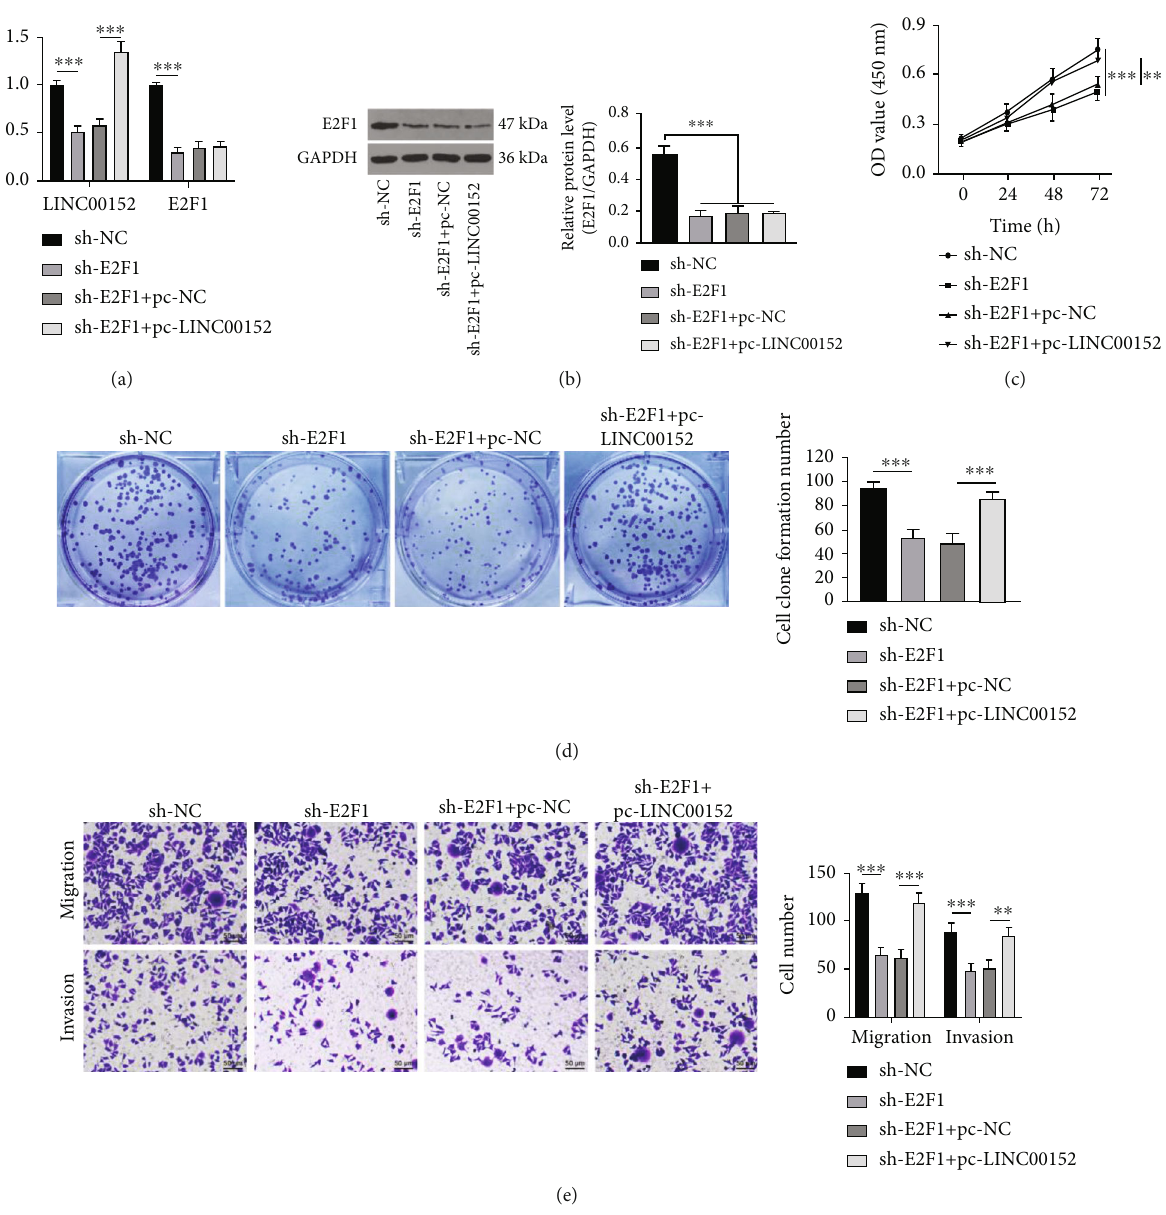
Figure 3: LINC00152 overexpression diminishes the repressive role of E2F1 knockdown on PTC cell growth and invasion. (a) Expression patterns of E2F1 and LINC00152 in TPC-1 cells assessed via RT-qPCR. (b) E2F1 expression patterns in TPC-1 cells calculated by Western blot analysis. (c, d) Cell proliferation detected by (c) CCK-8 and (d) colony formation assay. (e) Cell migration and invasion measured through Transwell assay. Repetitions = 3 . Data are expressed as mean ± standard deviation . One-way ANOVA was used to determine statistical signi fi cance. Tukey ’ s multiple comparisons test was applied for post hoc test. ∗∗ p < 0 : 01 ; ∗∗∗ p < 0 : 001